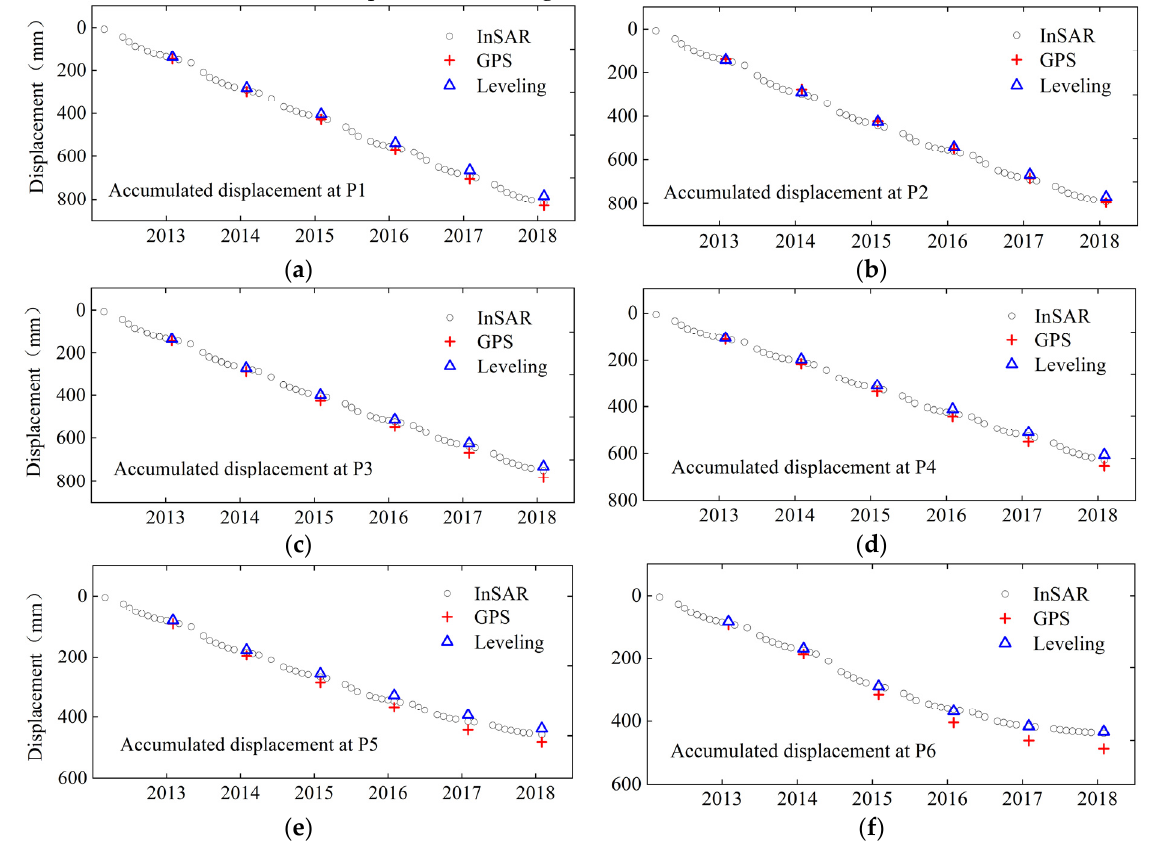
Figure 6. Comparison of accumulated land subsidence obtained by PSI, GPS, and leveling from 2013 to 2018. ( a ) Comparison result at P1. ( b ) Comparison result at P2. ( c ) Comparison result at P3. ( d ) Comparison result at P4. ( e ) Comparison result at P5. ( f ) Comparison result at P6.